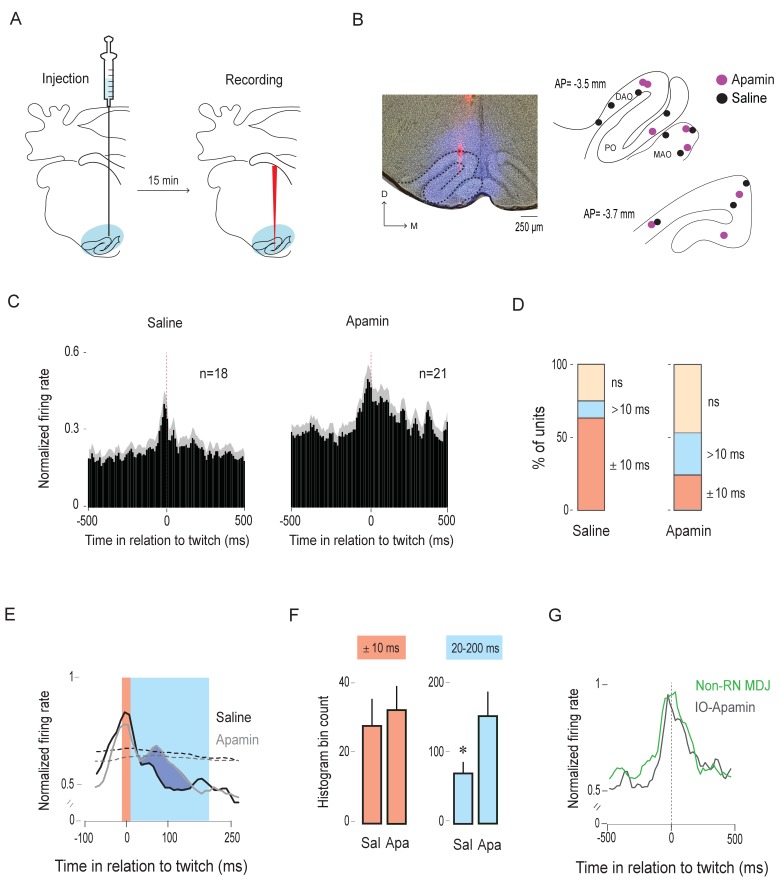
Apamin broadens the twitch-related peak in the IO.(A) Diagram depicting experimental design. Apamin or saline, mixed with 4% Fluorogold, was microinjected into the IO (blue shading). Fifteen minutes after the injection, the microsyringe was withdrawn and a recording electrode, coated with DiI (red vertical line), was inserted into the IO. Unit activity was recorded for 30 min. (B) Left: Representative coronal section showing drug diffusion in the IO (blue) and placement of DiI-coated recording electrode (red). Right: Reconstruction of electrode placements within the IO in two coronal sections for all pups in the saline (black dots; n = 10 pups) and apamin (purple dots; n = 8 pups) groups. DAO: dorsal accessory olive; MAO: medial accessory olive; PO: principal olive; D: dorsal; M: medial; AP: antero-posterior distance in relation to lambda. (C) Perievent histograms (10-ms bins) showing mean (+SEM; gray shading) normalized firing rates across all units triggered on twitches in the saline (n = 18) and apamin (n = 21) groups. (D) Stacked plots showing the percentage of units with significant activity within ±10 ms of twitch onset (red) and >10 ms after twitch onset (blue) in the saline and apamin groups. ns: not significant. (E) Perievent histograms (10-ms bins) showing IO unit activity in relation to twitches in the saline (black line) and apamin (gray line) groups. Data for both groups are pooled across significant units only (red and blue stacks in D; n = 13 saline units and n = 11 apamin units) and smoothed (tau = 10 ms). Red shaded area denotes ±10-ms time window around twitches. Blue shaded area denotes 20–200-ms time window following twitches. Black and gray dashed lines denote upper confidence intervals (p < 0.05) for the event correlations in the saline and apamin groups, respectively. (F) Mean histogram bin counts (area under the curve, +SEM) for firing-rate data in two time windows: the ±10-ms window around twitches (red) and the 20–200-ms window following twitches (blue) for the units in the saline (Sal; n = 12) and apamin (Apa; n = 11) groups. *p = 0.03. (G) Perievent histograms comparing normalized firing rates in relation to twitch onset for twitch-preceding units in the non-RN MDJ region (green line, same as in Figure 5F) with that of IO units in the apamin group (black line).10.7554/eLife.38213.019Figure 6—source data 1.Source data for panels C-G.